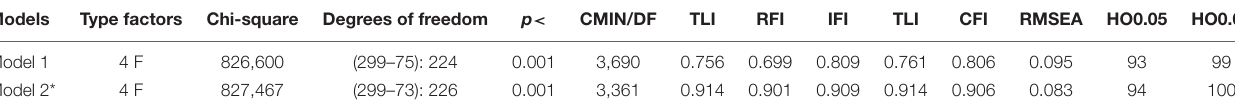
TABLE 6 | Statistical parameters of structural models. Models Type factors Chi-square Degrees of freedom